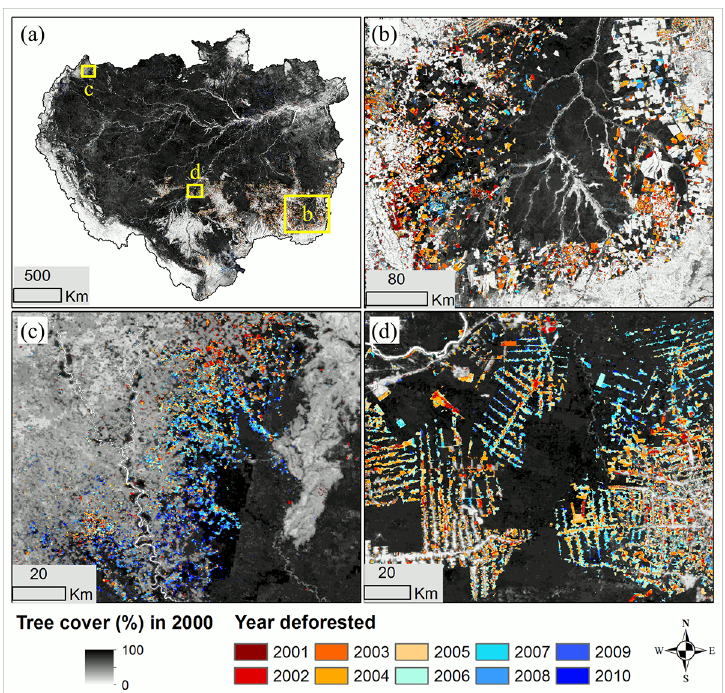
Fig 1. Deforestation year map derived from time-series of MODIS VCF tree cover dataset. (a) Overview of the Amazon basin with yellow boxes indicating the locations of regional close-ups. (b) Close-up over the Xingu river basin in Mato Grosso, Brazil. The large patch of remaining intact forest is a consequence of protection status in this area. (c) Close-up in Colombia. (d) Close-up in Rondonia,